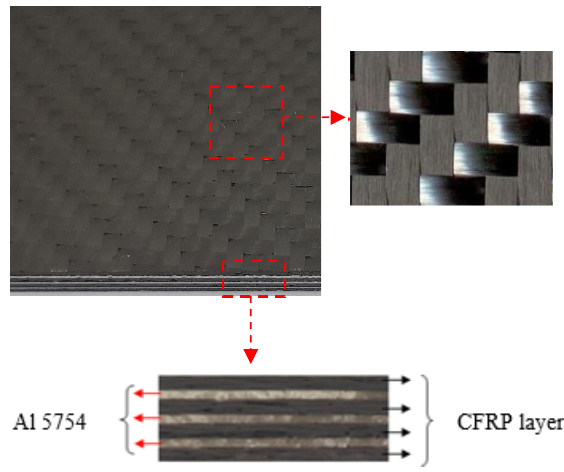
Figure 2. Top and cross-section view of a CARALL specimen.